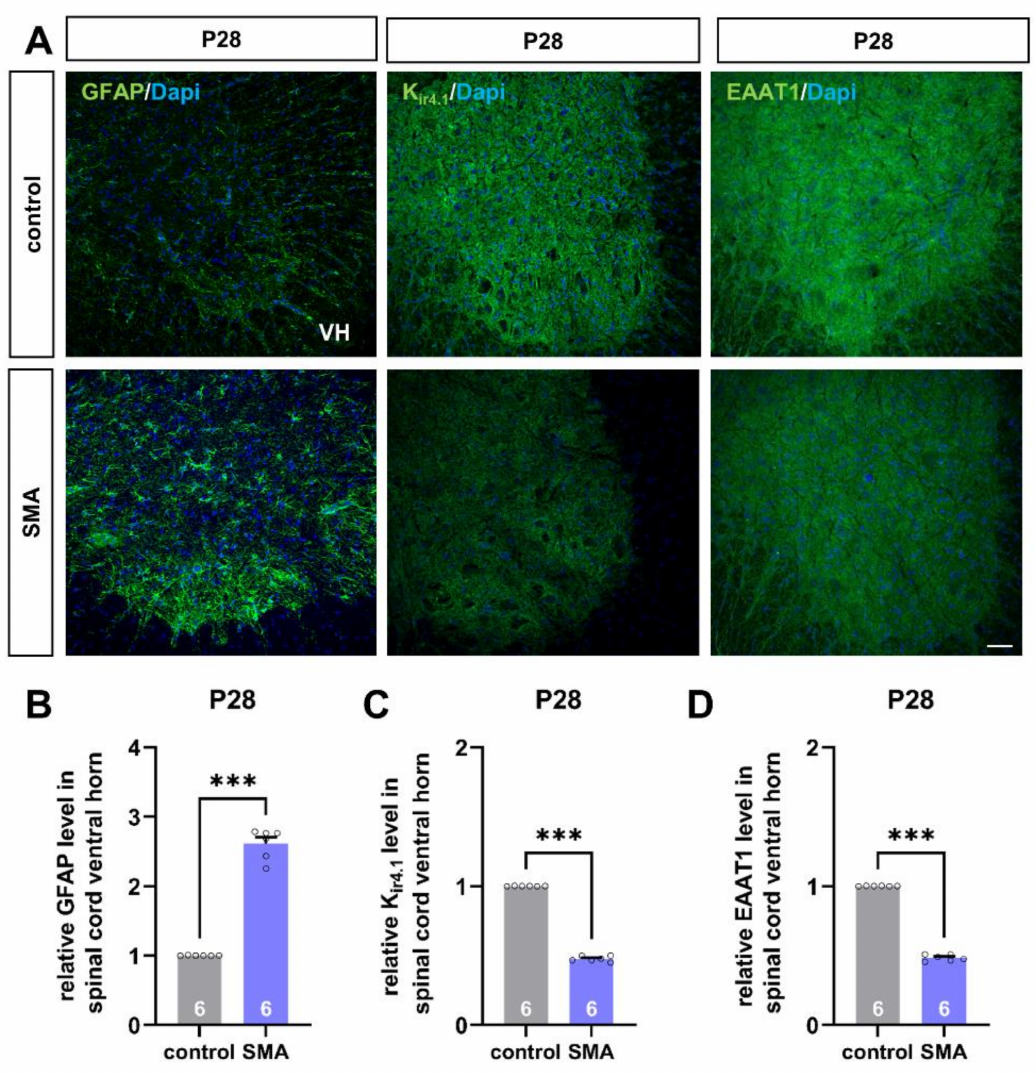
Figure 2. Spinal astrocytes proteins are altered in a mouse model of late-onset SMA before the first loss of motor neurons. ( A ) Immunostaining of astrocyte-specific proteins such as GFAP (green), K ir4.1 (green), and EAAT1 (green) in spinal cord slices of SMA and control mice at P28. Nucleic DNA was stained with Dapi (blue). ( B ) The relative GFAP level in SMA mice spinal cord ventral horns was increased compared to control mice (***, p < 0.001). ( C , D ) The relative level of K ir4.1 and EAAT1 was reduced in SMA mice, compared to control animals (***, p < 0.001). VH = ventral horn. n = 6 animals (see bars). Three slices per spinal cord were investigated. Each data point reflects the mean of those three spinal cord slices. Scale bar: 20 µ